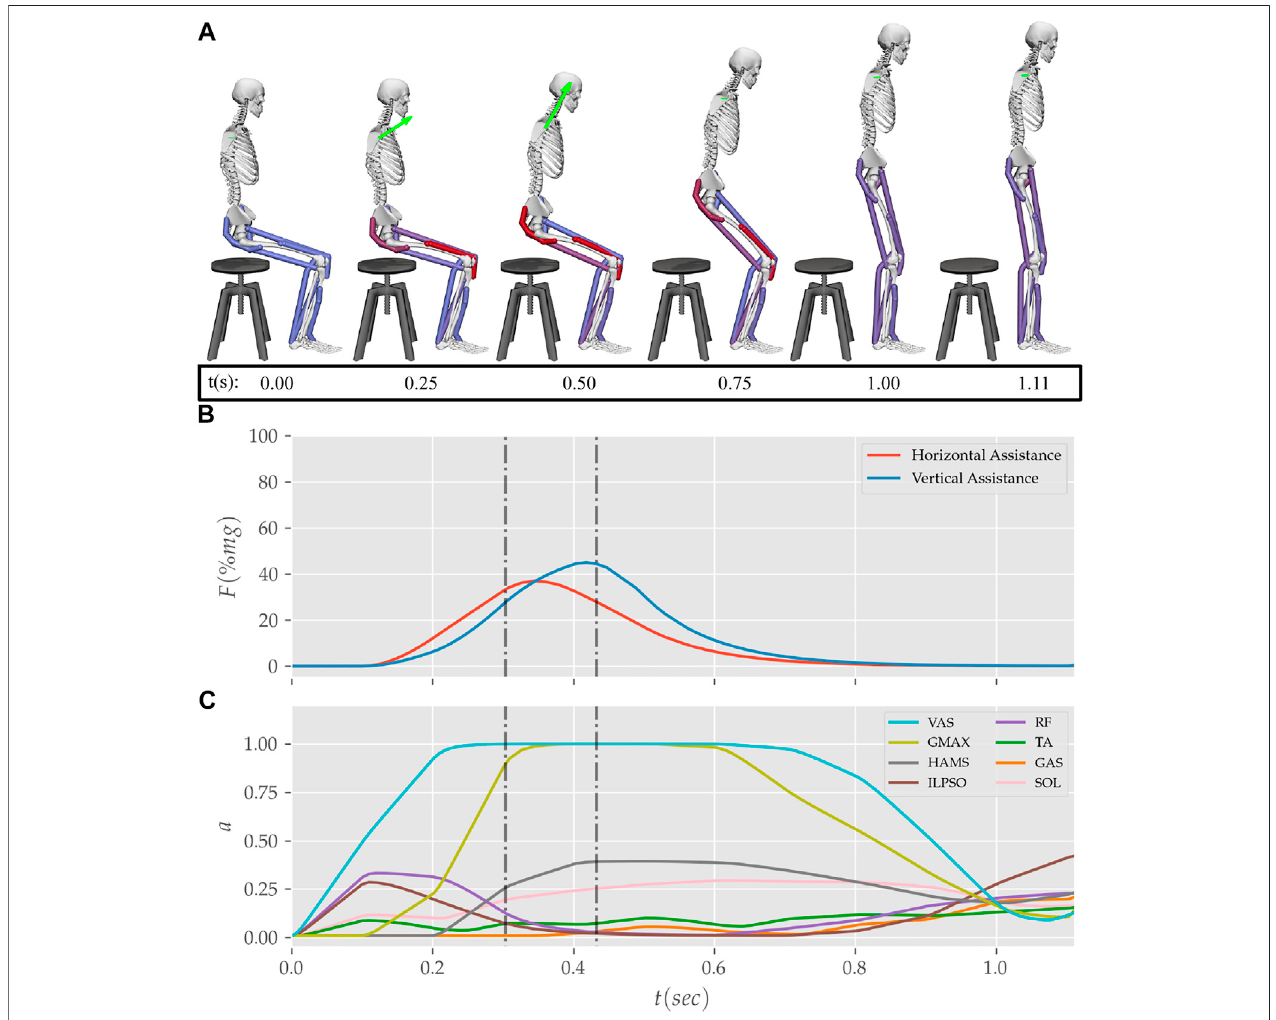
FIGURE 12 | (A) Postures, (B) external assistance and (C) muscle activation trajectories from the STS transition of the externally assisted 80% strength de fi cit model. The green arrow in (A) represents the resultant external assistance force.